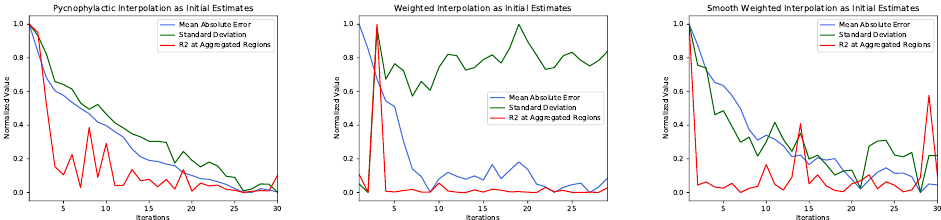
Figure 7. Disaggregation errors together with the standard deviation of the results for the overall amount of national